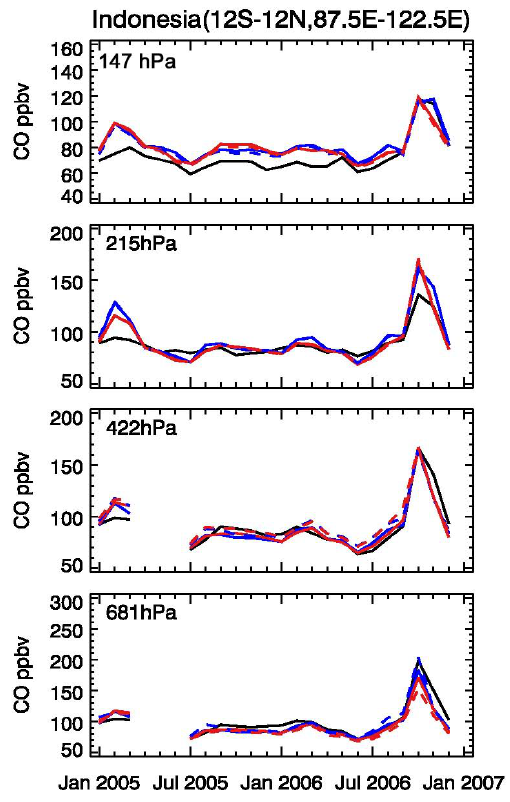
Fig. 25. Time series of TES CO (681 and 422hPa) and MLS CO (215 and 147hPa, scaled as in Fig. 8) (black) and model results for GEOS-4 (red) and GEOS-5 (blue) over Indonesia. Solid lines show the model results with the AKs applied, dashed lines show the model results without the